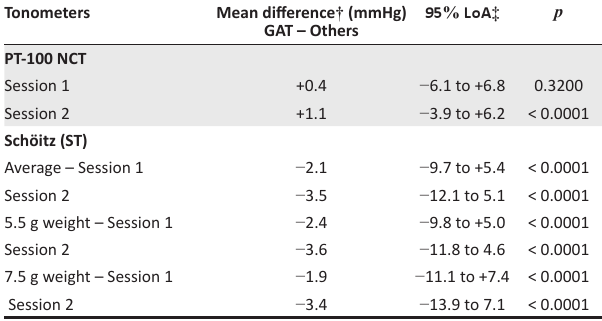
TABLE 1: Limit of agreement among the intraocular pressure values measured by the three tonometers in normal subjects. Goldmann applanation tonometer, PT-100 noncontact tonometer in the head upright position and all weights of Schiøtz tonometer. Tonometers